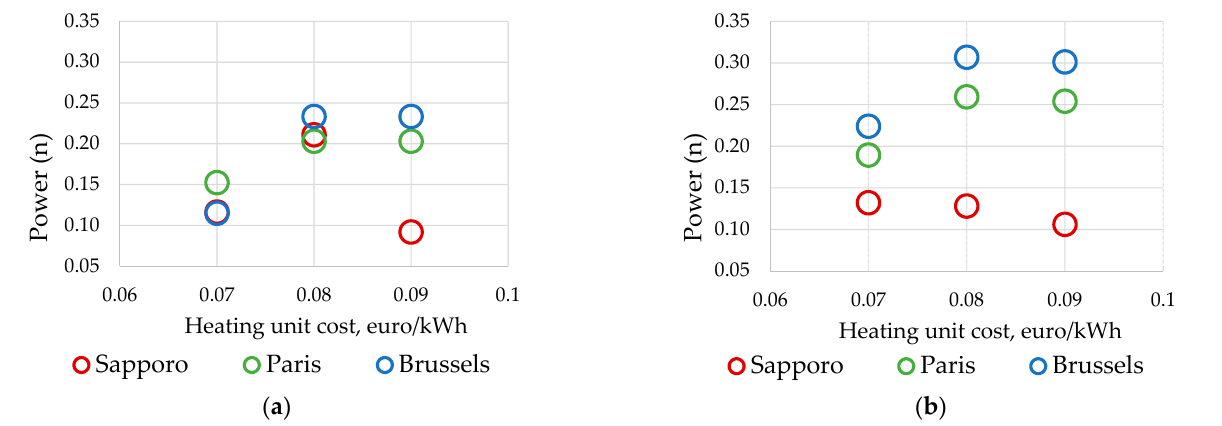
Figure 12. Range of power which gives no deviation compared to reference climate for cases of ( a ) Heating energy of single floor model, ( b ) Heating energy of a whole building model.